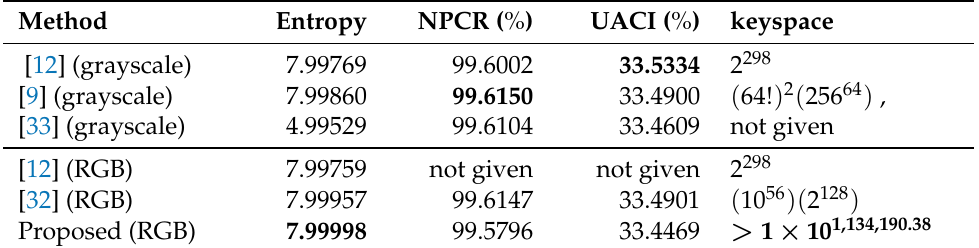
Table 3. Average values results of entropy, NPCR, UACI, and the keyspace domain for the proposed method and the four comparison methods.